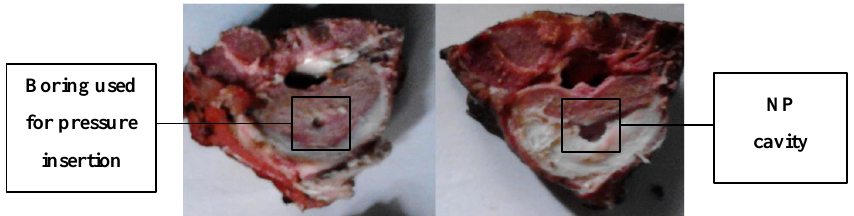
Figure 4. Images of MS sawed transversally after testing. It is visible the presence of a cavity in the NP region, indicating the pressurizing zone.